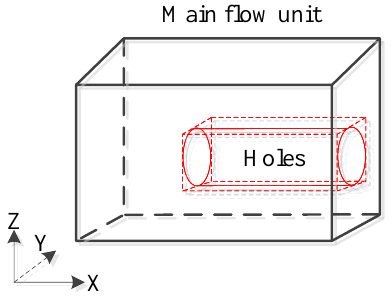
Figure 23. Bounding box collision method.